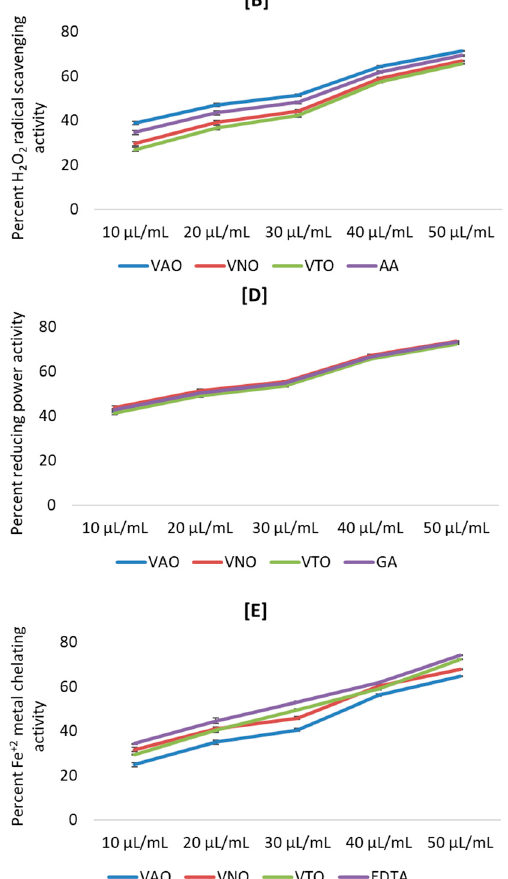
Figure 3. ( A – E ) Antioxidant activity for essential oils of Vitex species; ( A ) Percent DPPH radical scavenging activity; ( B ) Percent H 2 O 2 scavenging activity; ( C ) Percent NO radical scavenging activity; ( D ) Percent reducing power activity; ( E ) Percent Fe 2+ metal chelating activity.